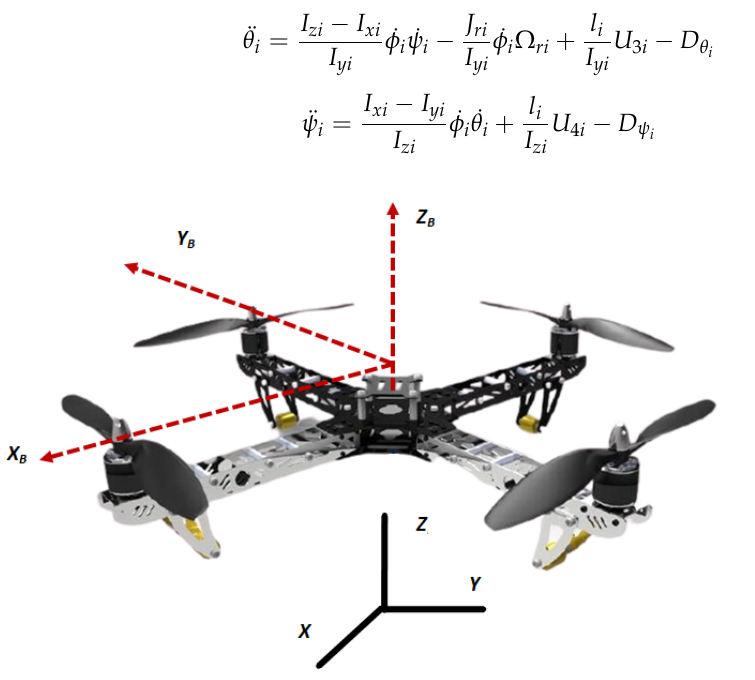
Figure 1. Quad-rotor in inertial reference frame.